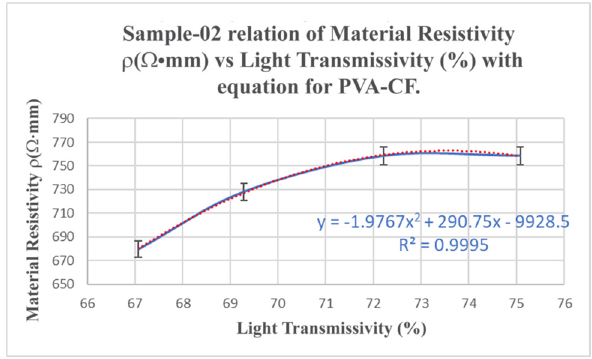
Figure 27: Sample - 02 ( CF:PVA = 0.2:30 ) material resistivity ρ ( Ω mm ) versus light transmittance ( % ) with equation for PVA - CF. The dotted lines represent the polynomial fi tted curve and the linear fi tted.